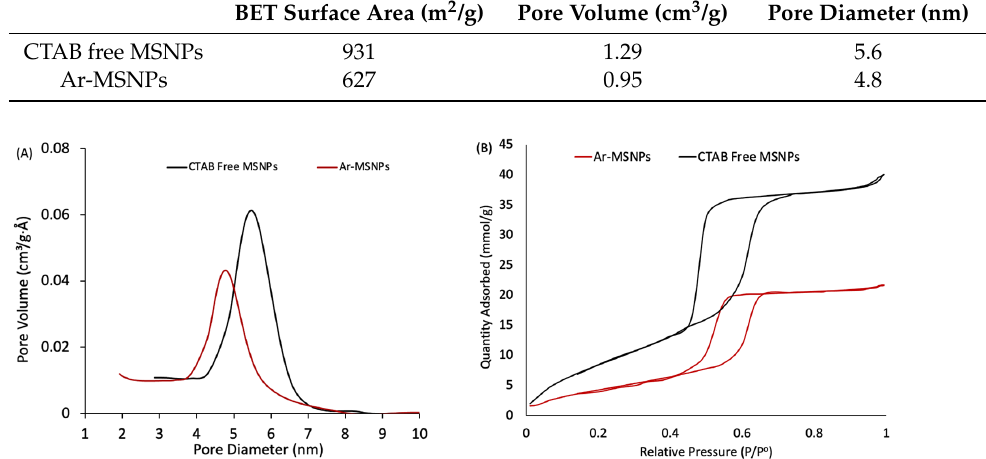
Figure 4. Physical properties of CTAB free MSNPs and Ar-MSNPs: ( A ) BJH pore size distribution, and ( B ) nitrogen adsorption/desorption isotherms.